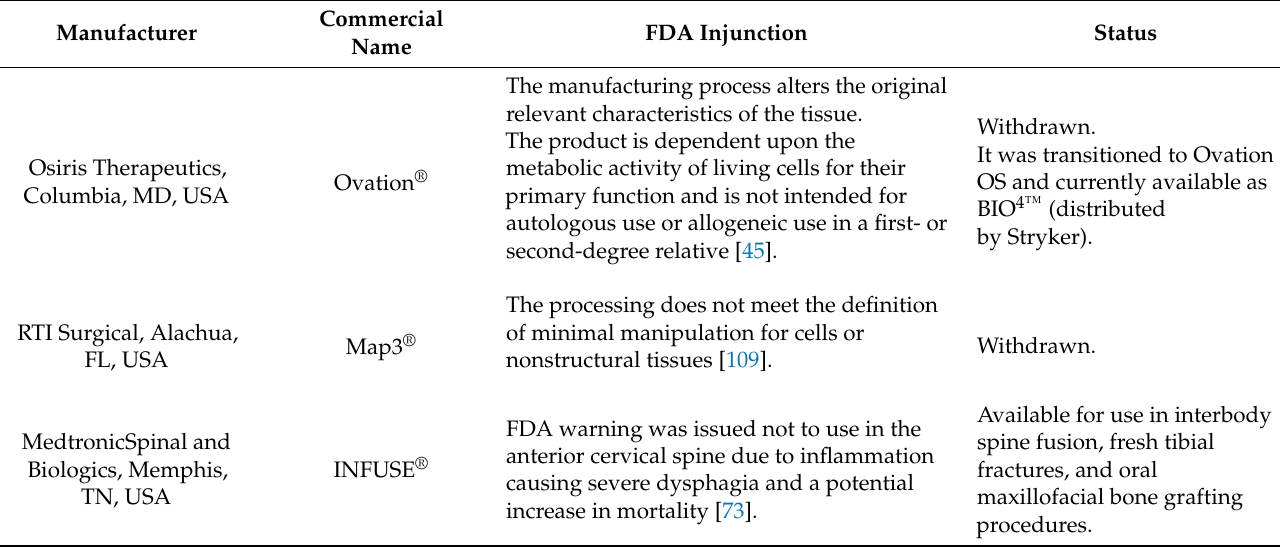
Table 4. Summary of withdrawn or warned commercial bone